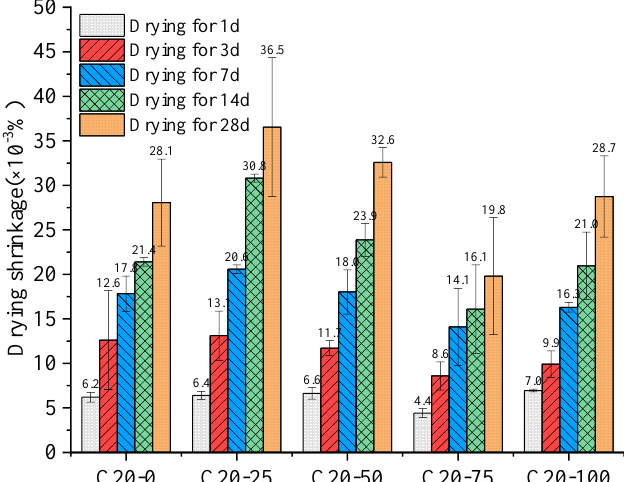
Figure 19. Drying shrinkage of C20